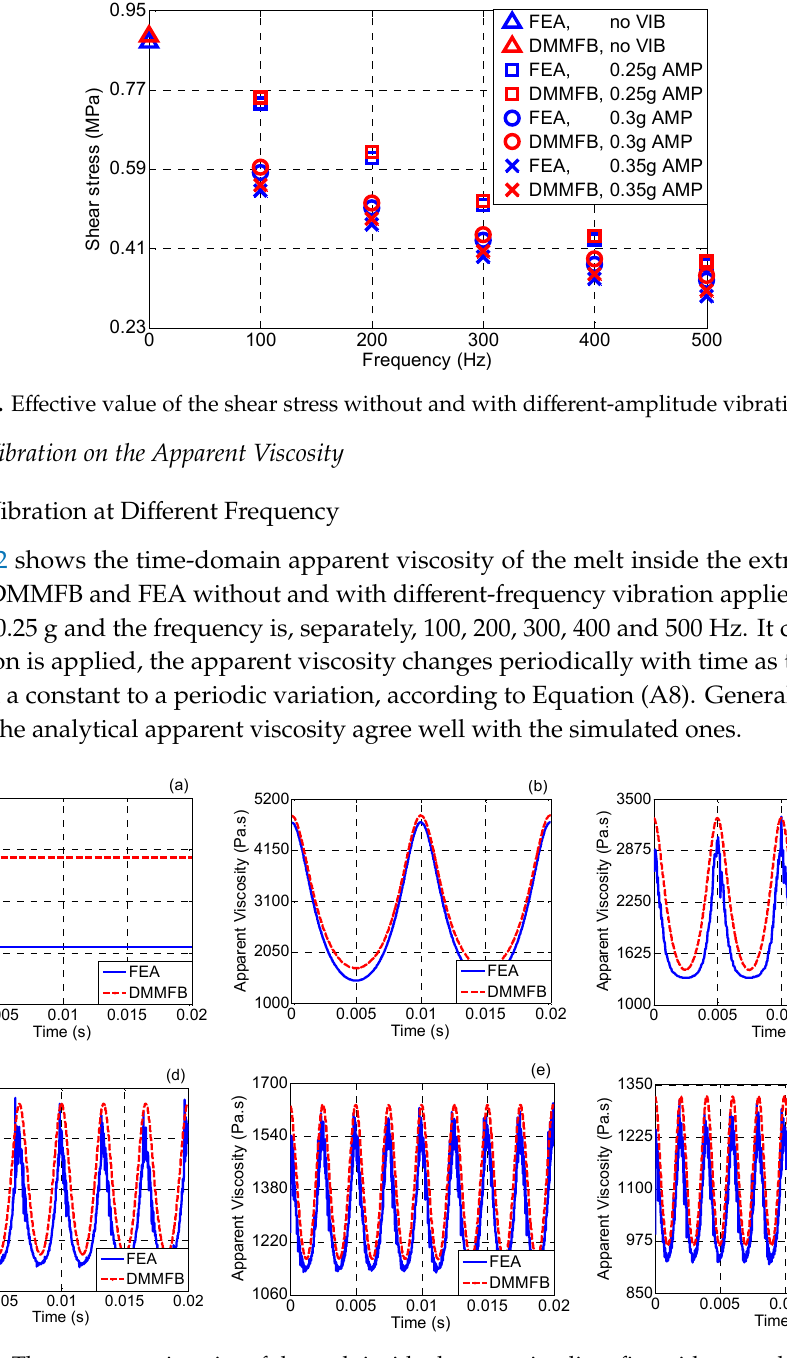
Table 9. Effective value of the apparent viscosity without and with 0.25 g vibration applied at different frequencies. Frequency (Hz)